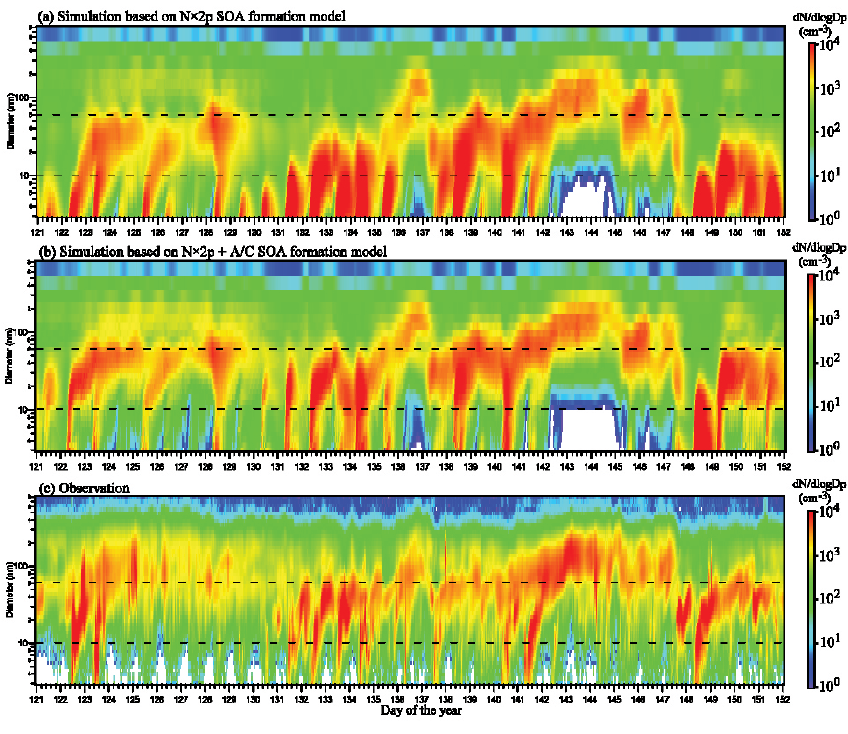
Fig. 4. A comparison of the simulated particle size distribution evolution based on (a) previous N × 2p SOA formation model (i.e., no oxidation aging and explicit condensation of LV-SOG) and (b) present N × 2p+A/C SOA formation model described in Sect. 2, with (c) those observed in a boreal forest site (Hyyti¨al¨a, Finland) during May, 2005. The simulations are the results for the surface layer. The observation data are from the CREATE Aerosol Database at NILU and Markku Kulmala is the PI of the data. Further information of the size distribution measurements can be found in Laakso et al. (2004) and Ehn et al. (2007). The horizontal lines at 10nm and 60nm are added to guide the visual comparison of particle size